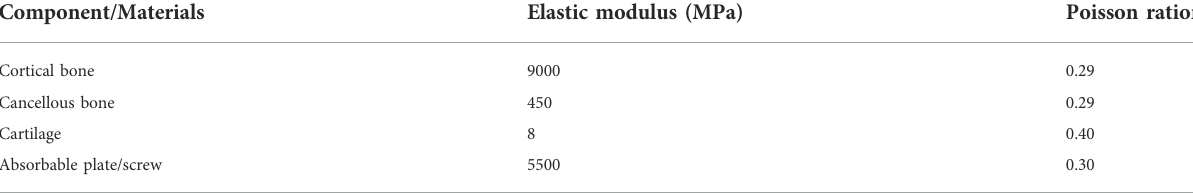
TABLE 1 Mechanical properties of physiological structures and internal fi xation implants used to simulate fi nite element models.